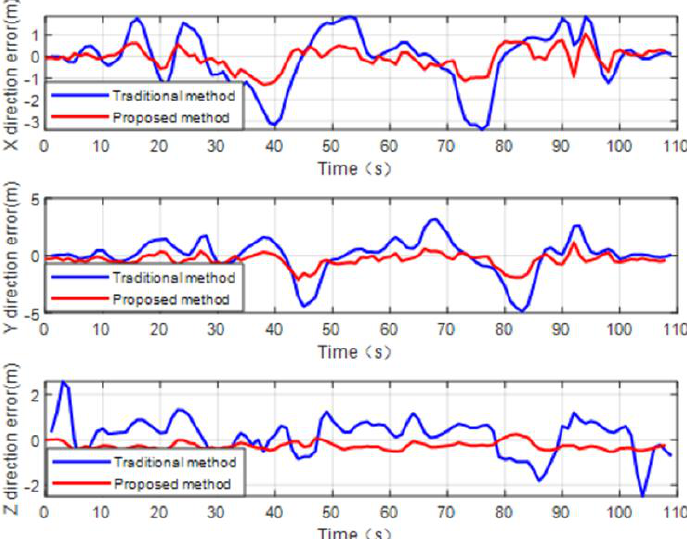
Figure 8. Follower UAV’s positioning error curve comparison by using traditional multi-leader UAV CP method based on relative ranging and the proposed method.